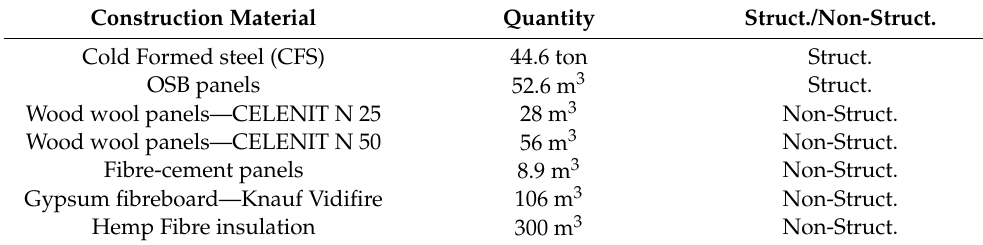
Table 5. Bill of materials: load-bearing walls.